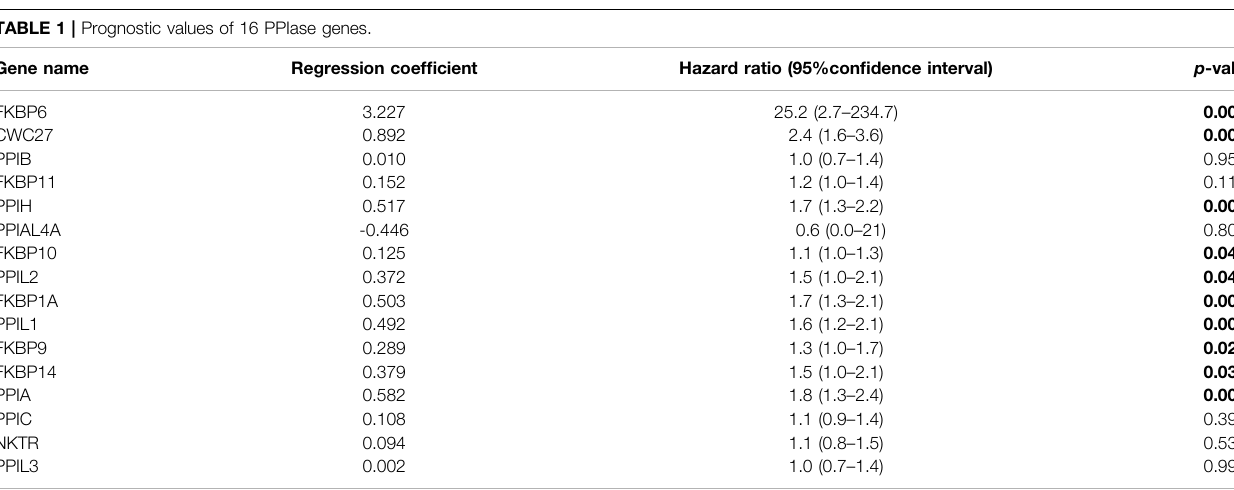
Abbreviation: PPIase, peptidyl prolyl cis – trans isomerase. Bold values indicate p <